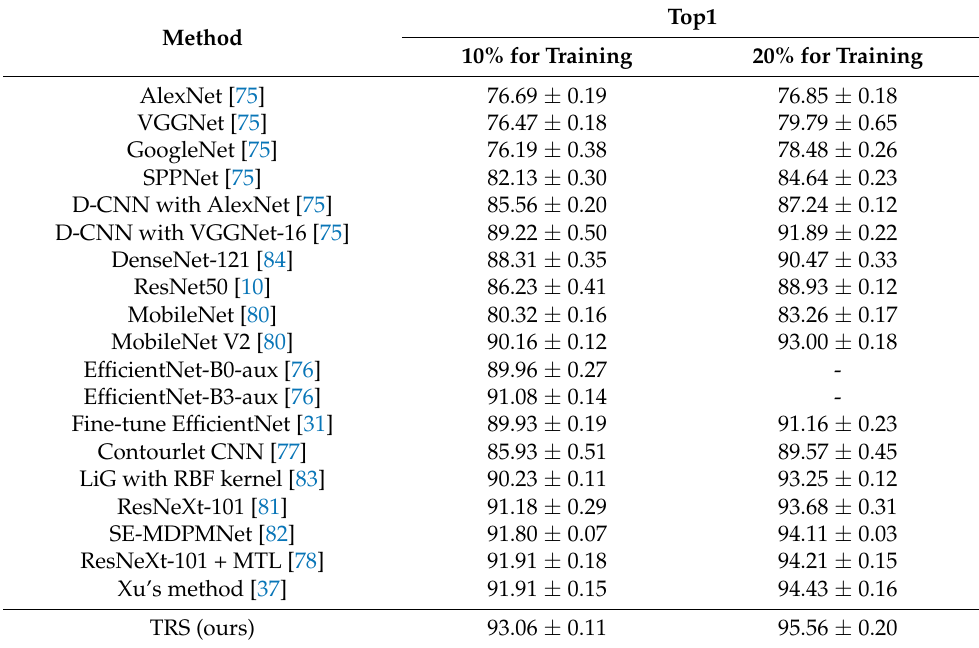
Table 5. Classification accuracy on NWPU-RESISC45 Dataset.